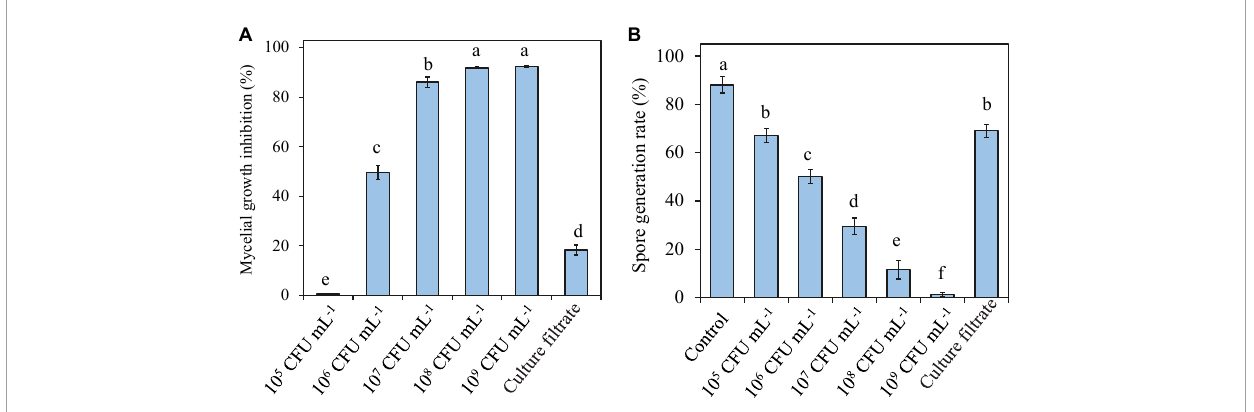
FIGURE3 Effects of P. syringae B-1 cells and culture filtrate on mycelial growth inhibition (A) and spore generation (B) of B. dothidea in vitro. Strain B-1 cells were used at 1 × 10 5 CFU mL– 1 to 1 × 10 9 CFU mL– 1 , and sterile distilled water was used as the control. Each column represents the mean and vertical bars represent the SD of four replicates. Different letters above the bars indicate significant differences ( p < 0.05) between the control and the different treatments of strain